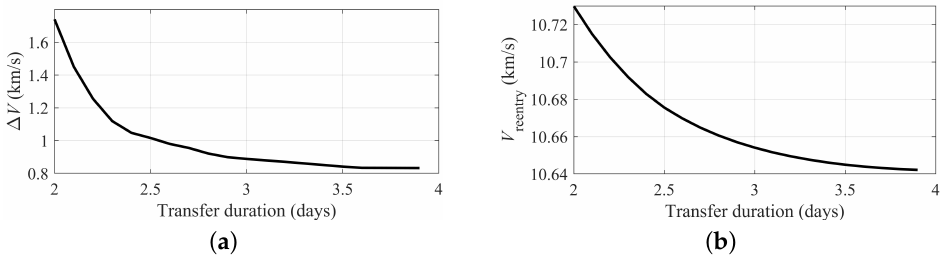
Figure 10. Relationship between transfer duration and velocity increment and re-entry velocity. ( a ) ∆ V to the transfer duration; ( b ) The re-entry velocity to the transfer duration.